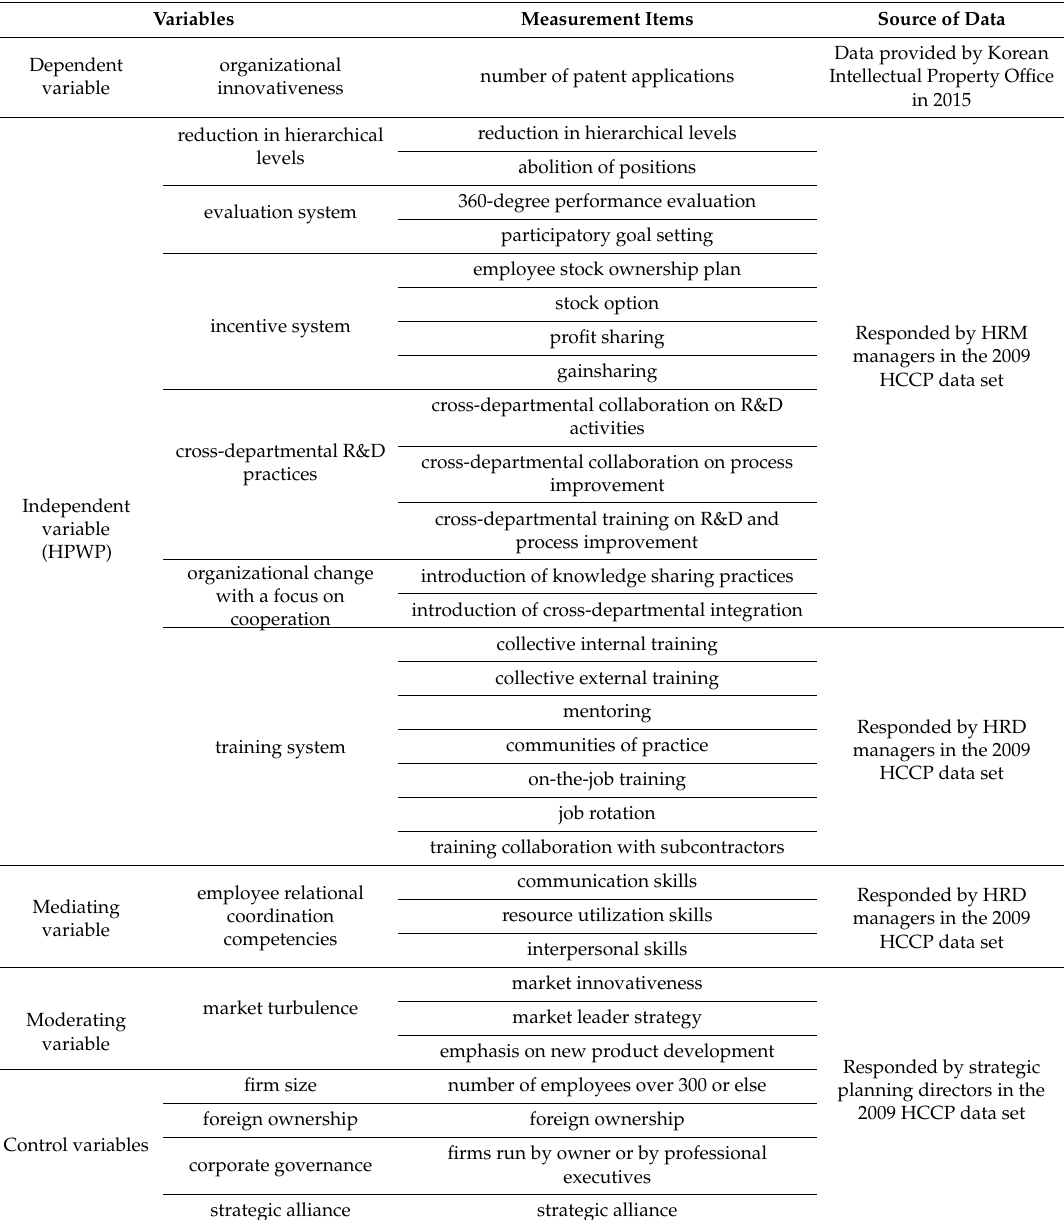
Table 1. Study variables and measurement items.